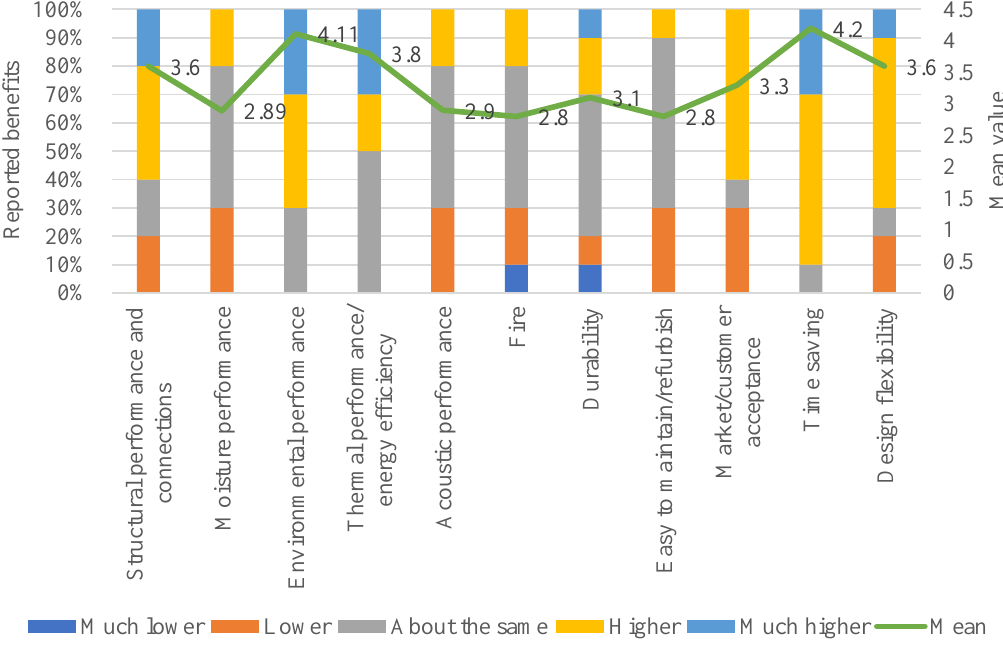
Figure 3. The reported benefits of MTC projects over the traditional construction projects.